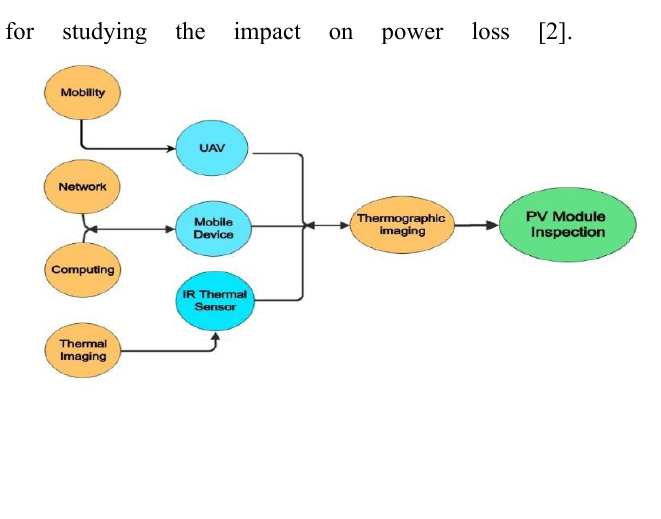
Figure 1. Source of Thermal images for PV Inspection Module